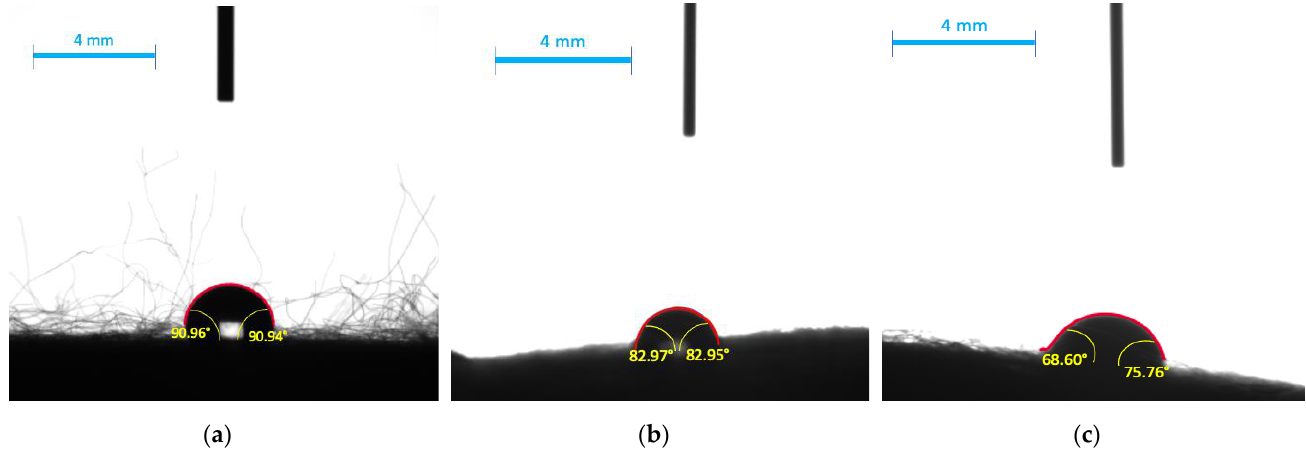
Figure 4. Infrared spectra of polystyrene nanofibers (PS) and polystyrene nanofibers with alginate hydrogel immobilized bacteria (PS/Alg).